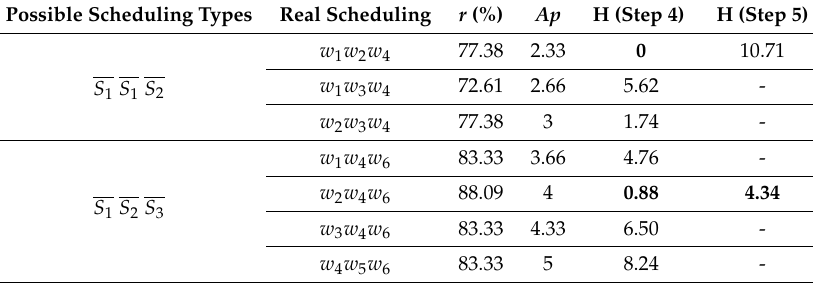
Table 2. Motivation example for explaining part 2 of the